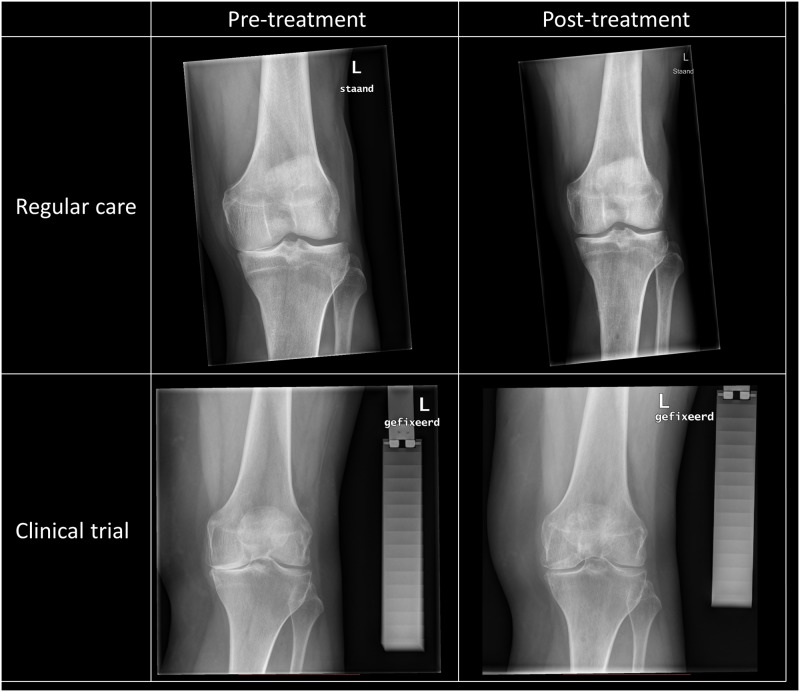
Representative radiographs pre-treatment and one year post-treatment for regular care and clinical trial patient.Note the aluminum step wedge needed for joint space width quantification as used in clinical trials.